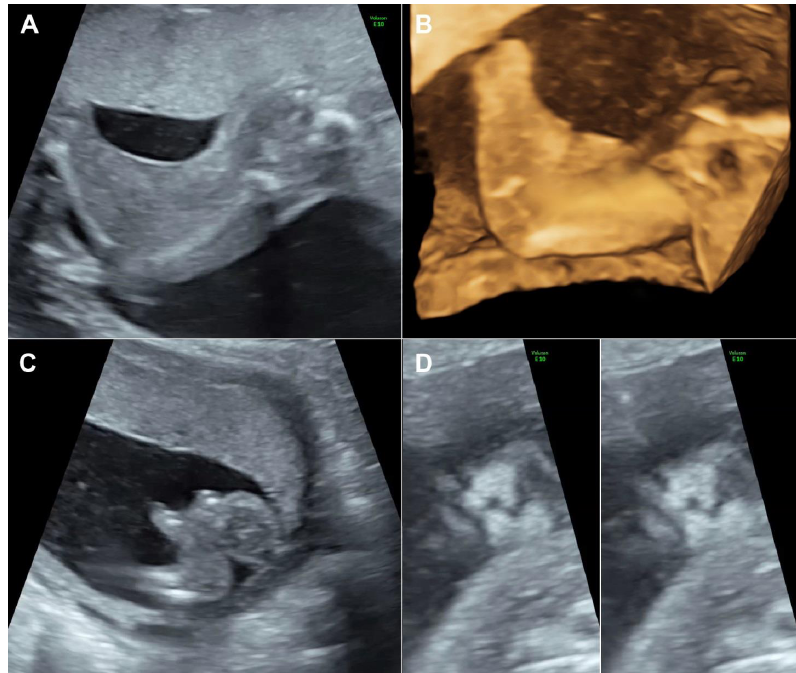
Figure 1. ( A ) Webbing from the posterior aspect of the thigh extending to the heels; ( B ) 3D-US reconstruction of the lower limb shows popliteal webbing; ( C ) Club foot shows ectrodactyly; ( D ) Coronal view of the fetal face shows bilateral grooves of the upper lip (left: superficial plane; right: deeper plane).